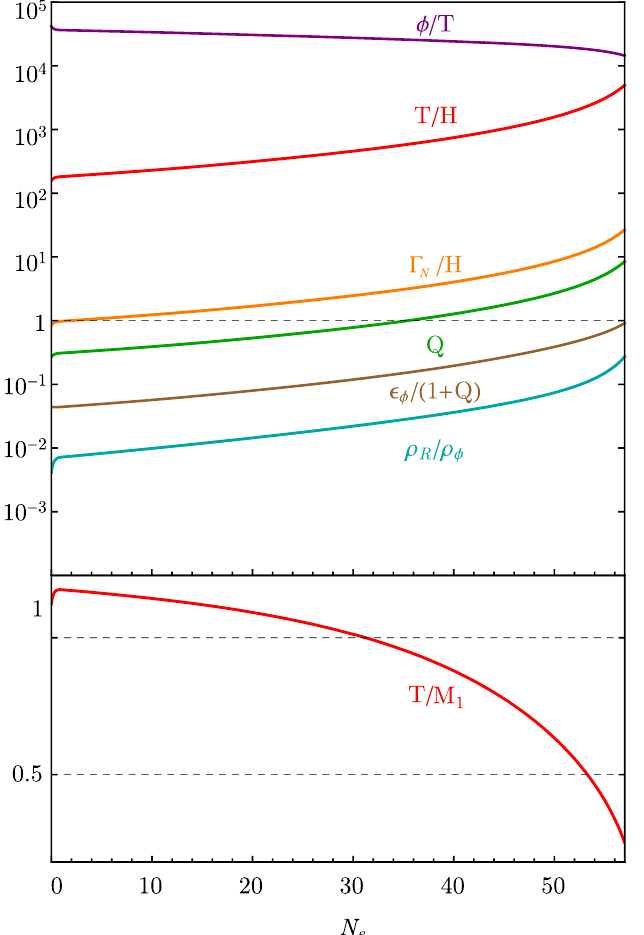
Figure 1 . Inflationary dynamics for V ( φ ) = λφ 4 as a function of the number of e-folds. The total number of e-folds of inflation is N eq ≈ 58 with ( n s , r ) = (0 . 967 , 2 . 6 × 10 − 4 ) (nearly-thermal inflaton fluctuations). The number of relativistic degrees of freedom during inflation is approx- imately constant, g ∗ ≈ 19 . The ‘reheating’ temperature is T R ≈ 7 . 5 × 10 13 GeV.